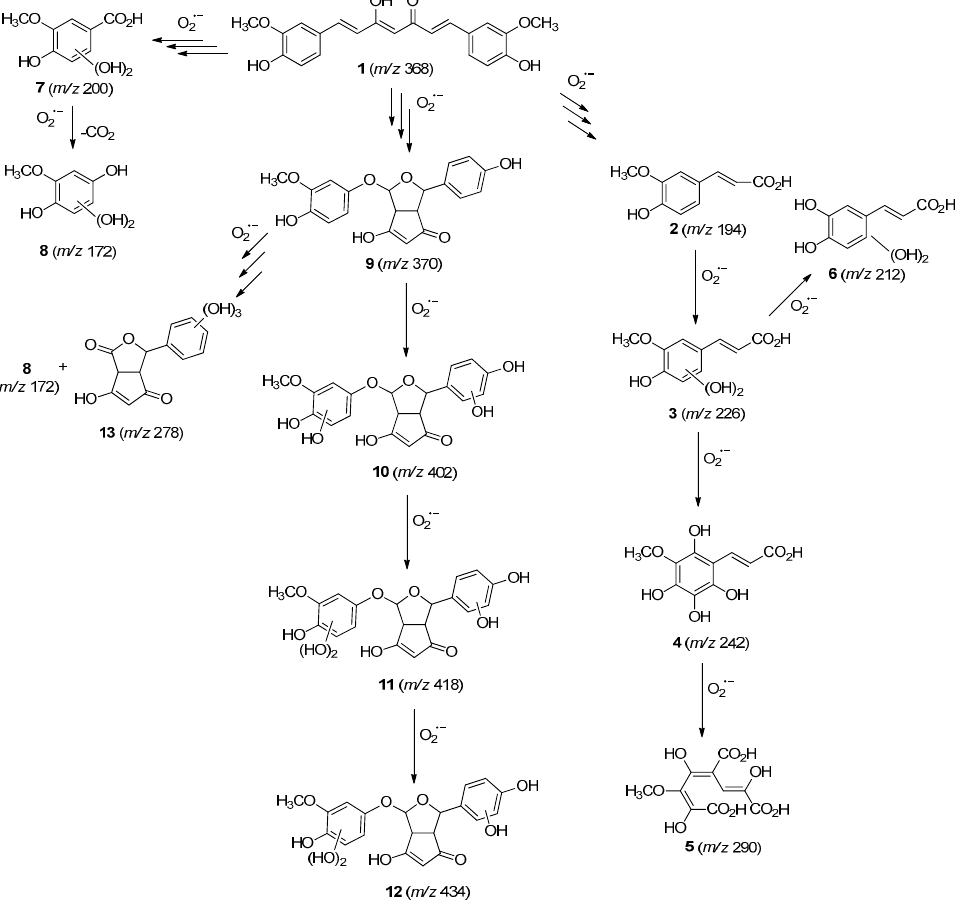
Figure 3. Proposal for formation of curcumin photodegradation byproducts.